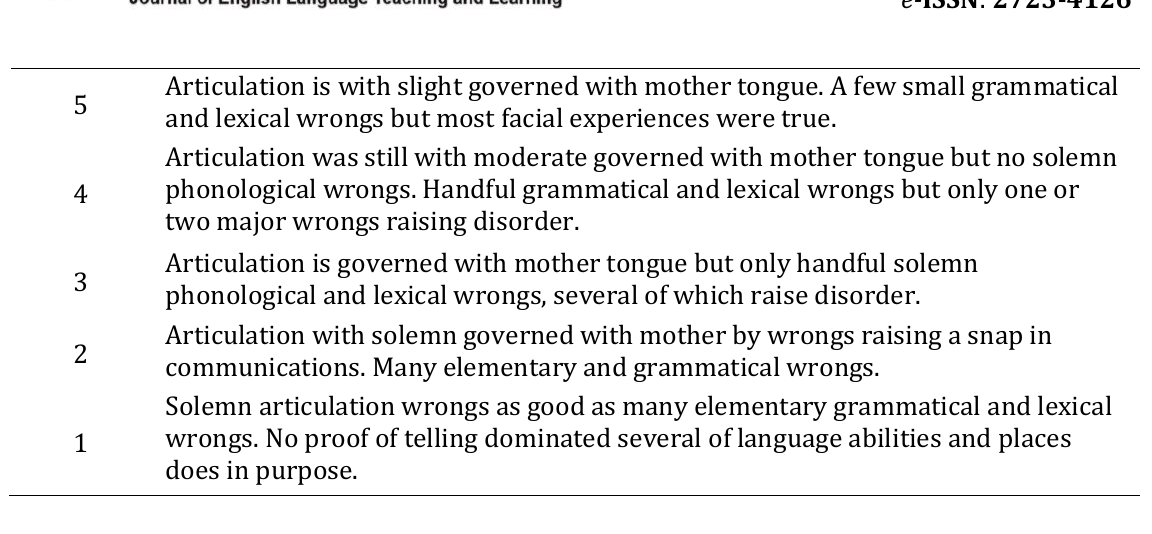
Table 2. Fluency